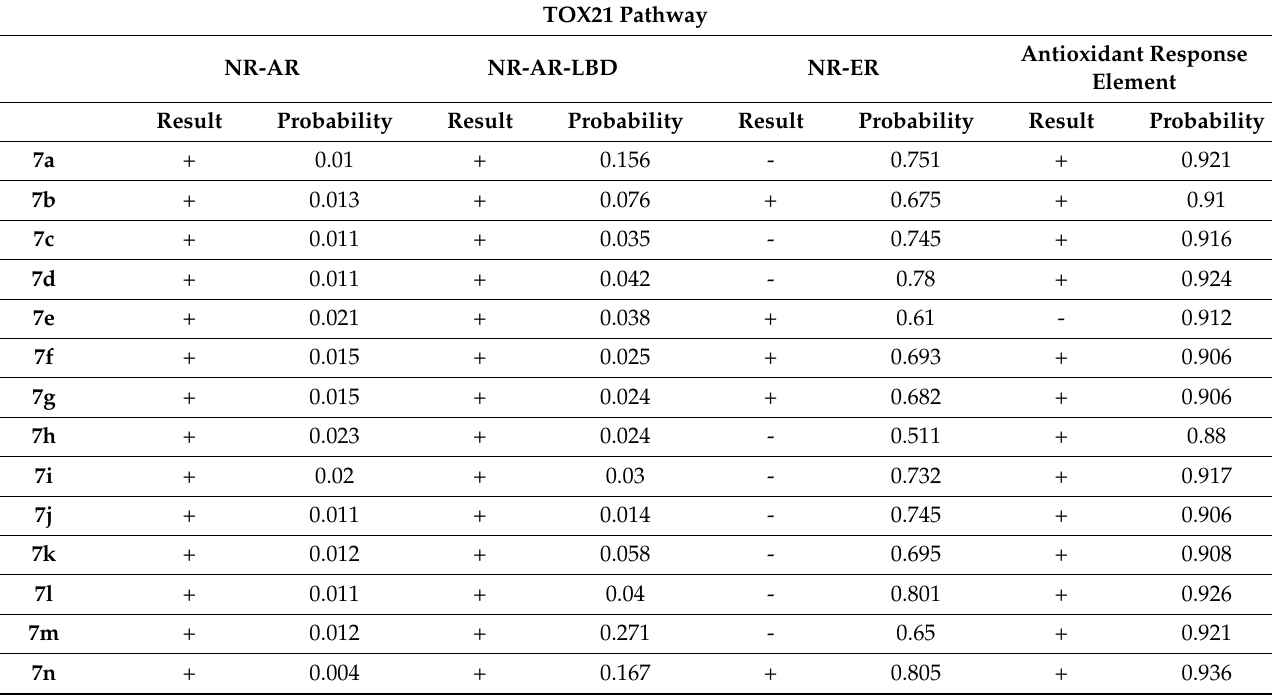
Table 10. Various Toxicological parameters of selected compounds.